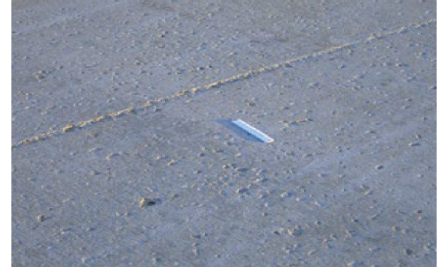
Figure 6: Popouts or mortar flaking [12].